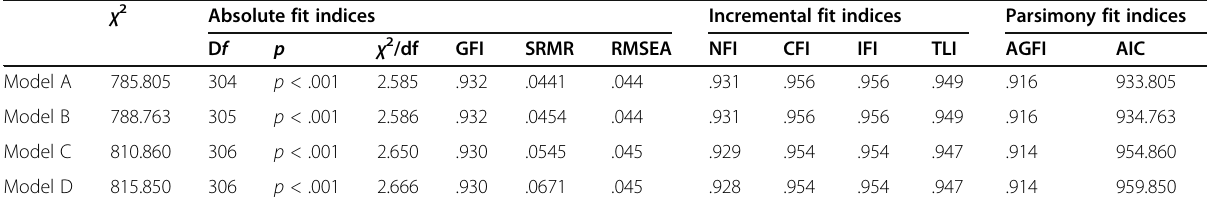
Table 3 Fit indices of the SEM structural models ( n =